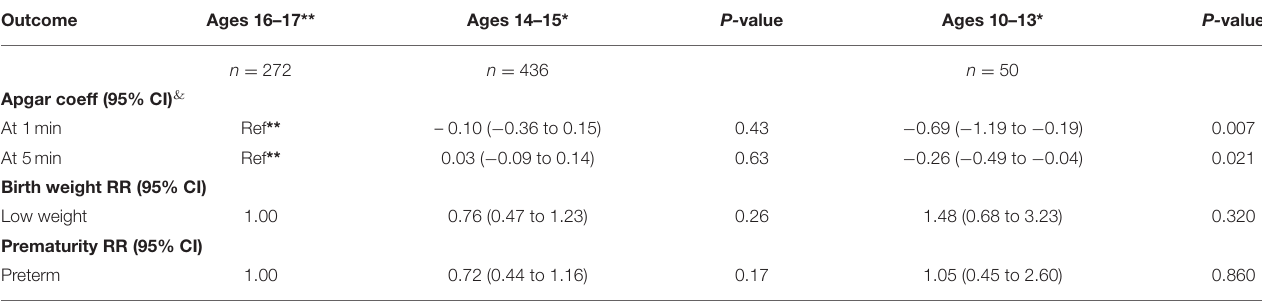
TABLE 3 | Mean difference and relative risk of neonatal